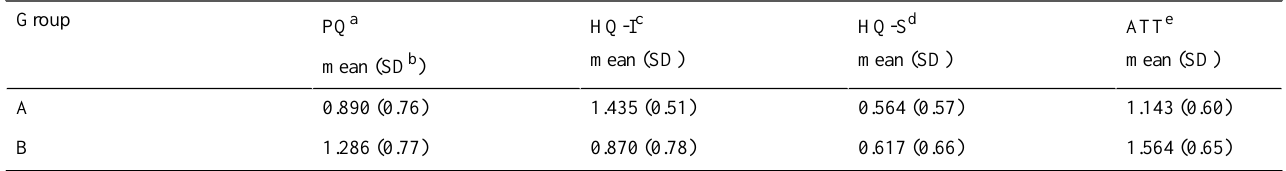
Table 7. Aggregated values calculated for the four qualities covered by AttrakDiff 2: pragmatic quality (PQ), identification (HQ-I), stimulation (HQ-S), and attractiveness (ATT) for groups A and B (both